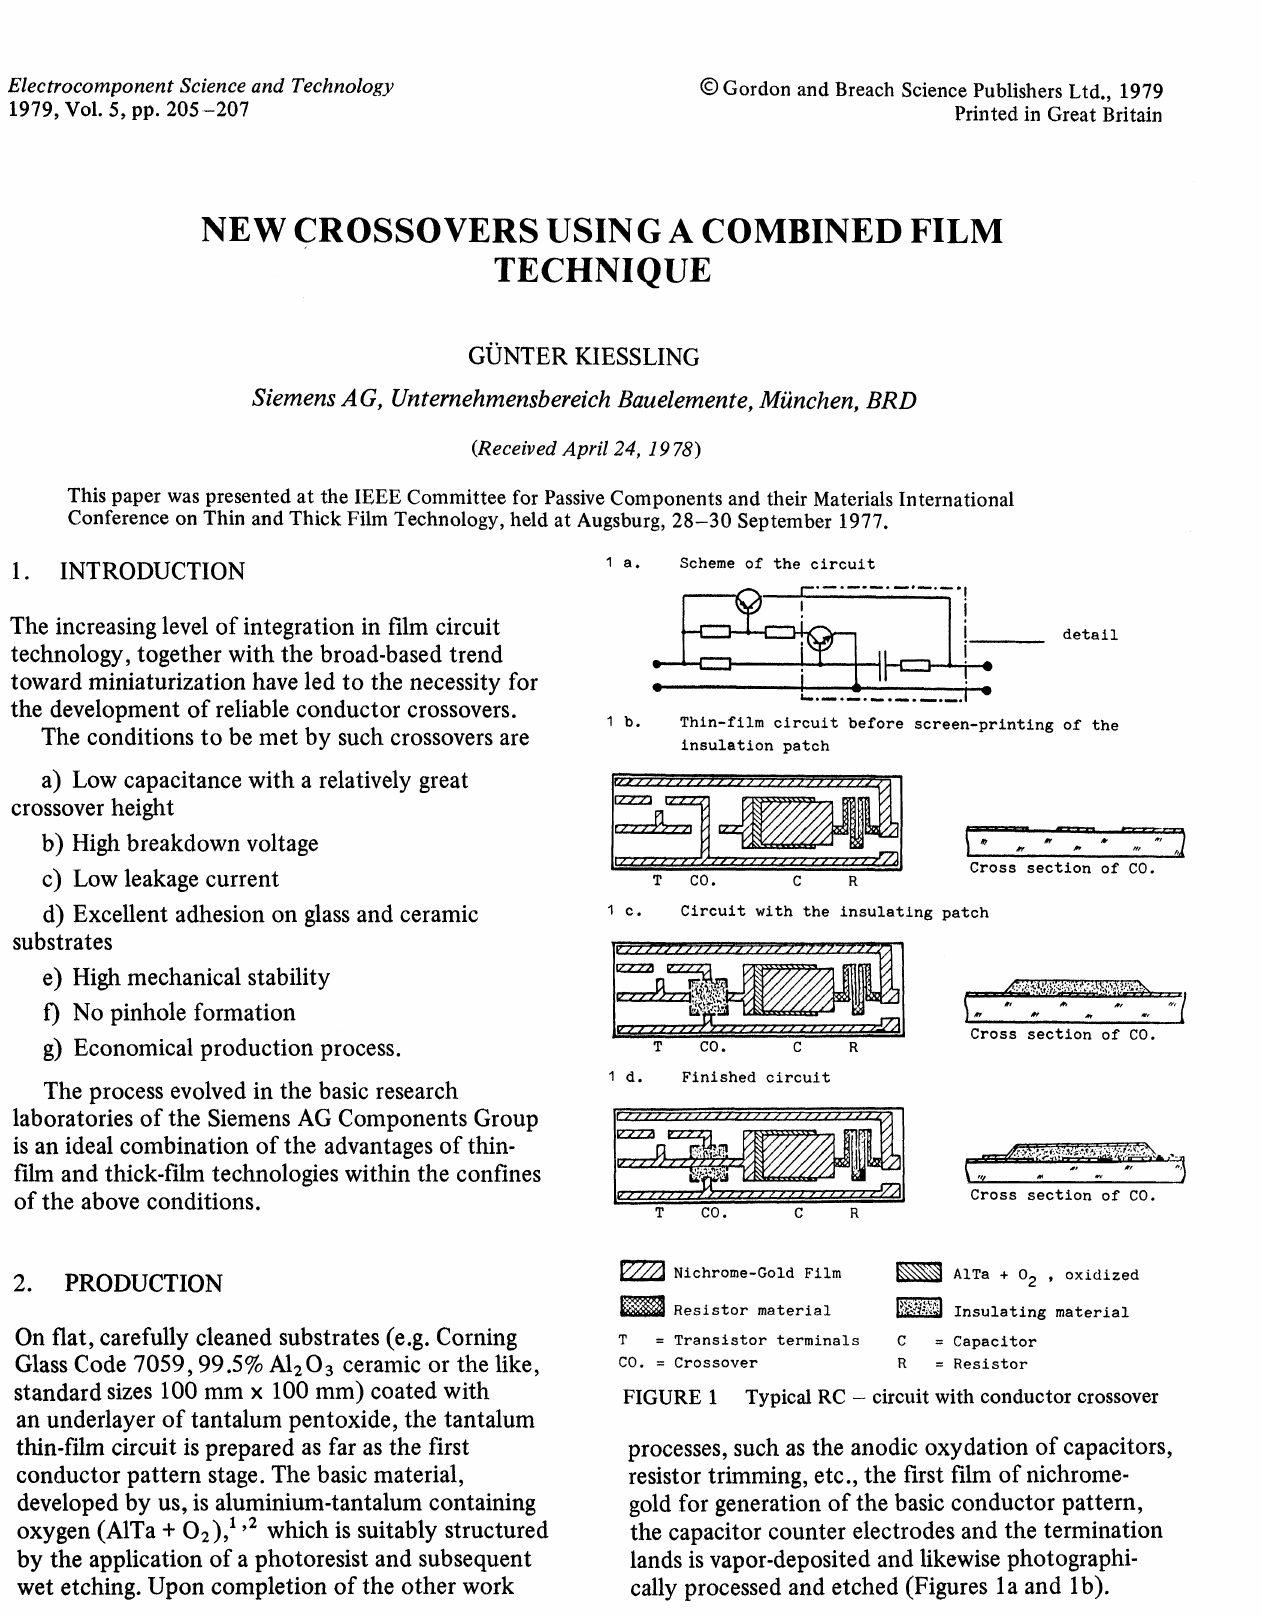
FIGURE Typical RC circuit with conductor crossover processes, such as the anodic oxydation of capacitors, resistor trimming, etc., the first film of nichrome- gold for generation of the basic conductor pattern, the capacitor counter electrodes and the termination lands is vapor-deposited and likewise photographi- cally processed and etched (Figures a and